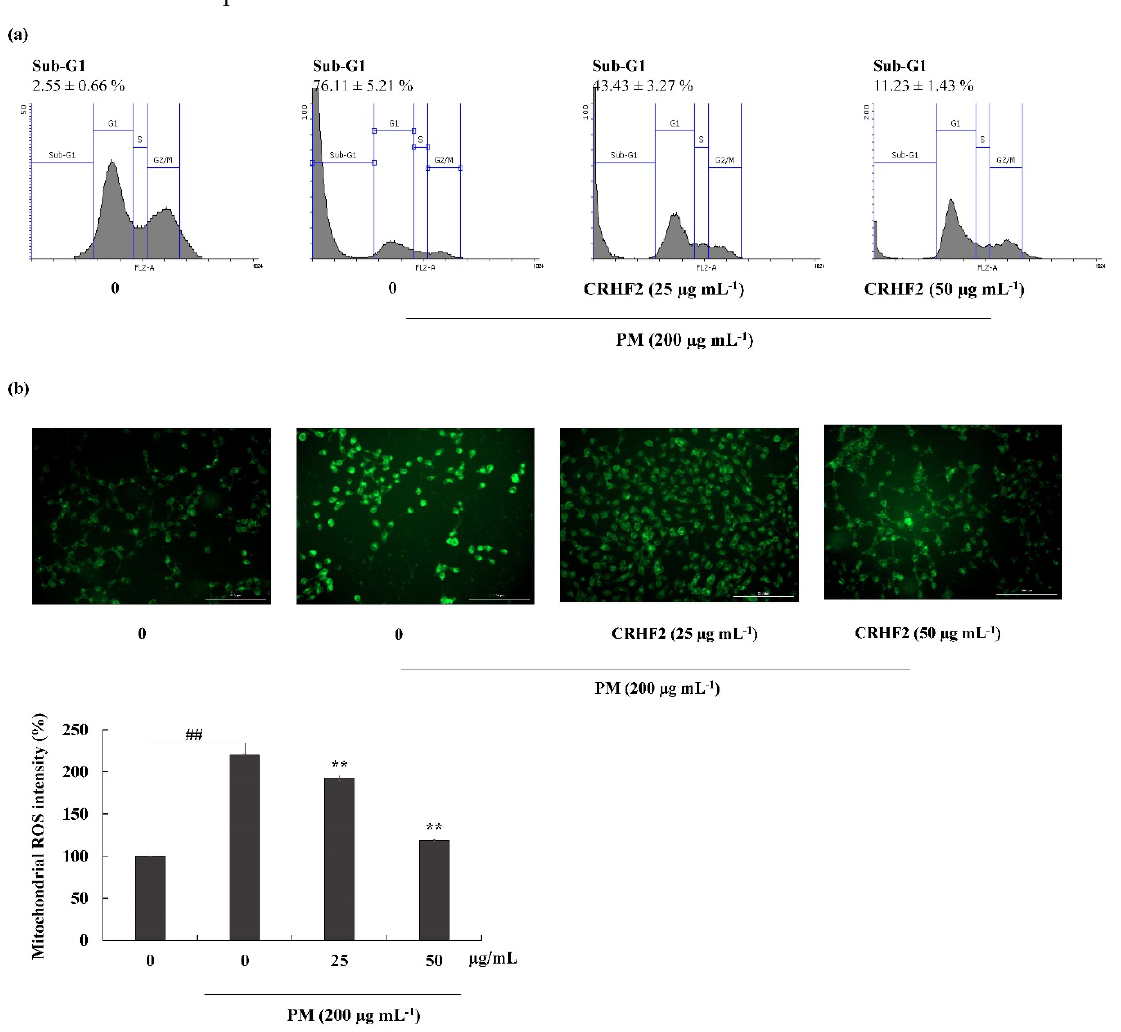
Figure 4. Cell-cycle analysis and mitochondrial ROS analysis in CRHF2-treated cells. ( a ) Cell-cycle analysis of sub-G1 cell population. PM affected cell-cycle progression and it was recovered with CHRF2 treatment. Cells were treated with CRHF2 and induced with PM. Harvested cells were evaluated via flow cytometer. ( b ) Mitochondrial ROS analysis by DHR123 staining. Triplicated independent experiments (n = 3) were involved to confirm the repeatability. Results are represented as mean ± SD; ** p < 0.01. (# denotes significance compared to control while * represents significance compared to PM-treated group).